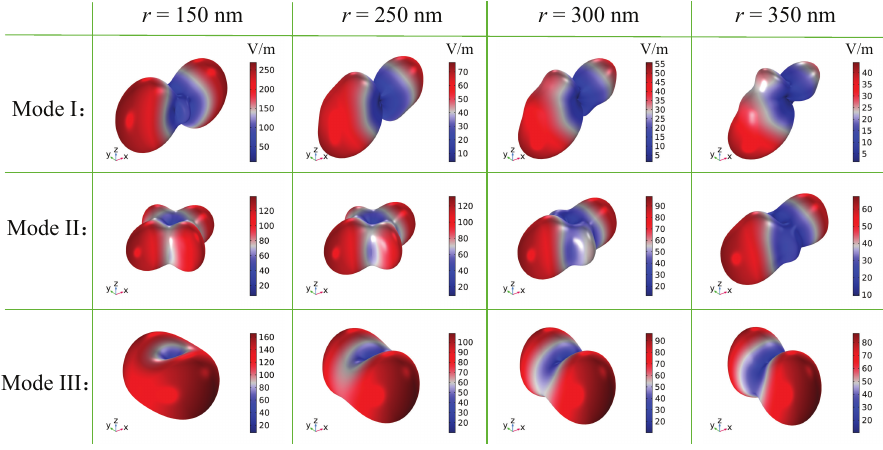
Figure 8. Radiation patterns of the unit cell under different air-hole radii r